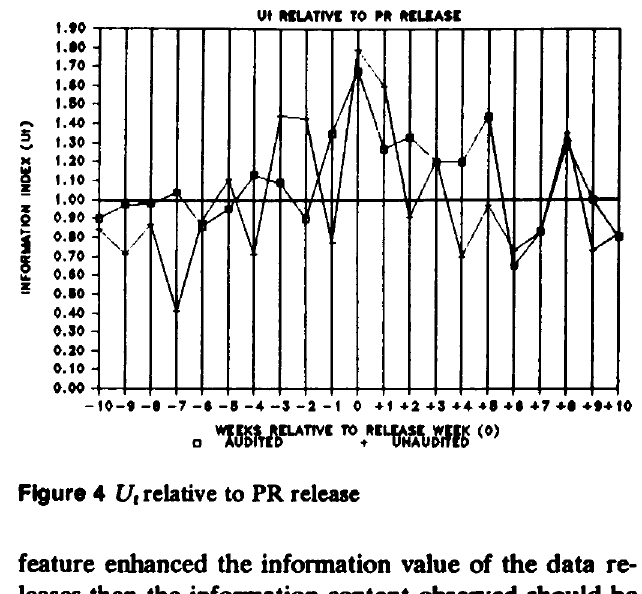
Figure 4 U, relative to PR release